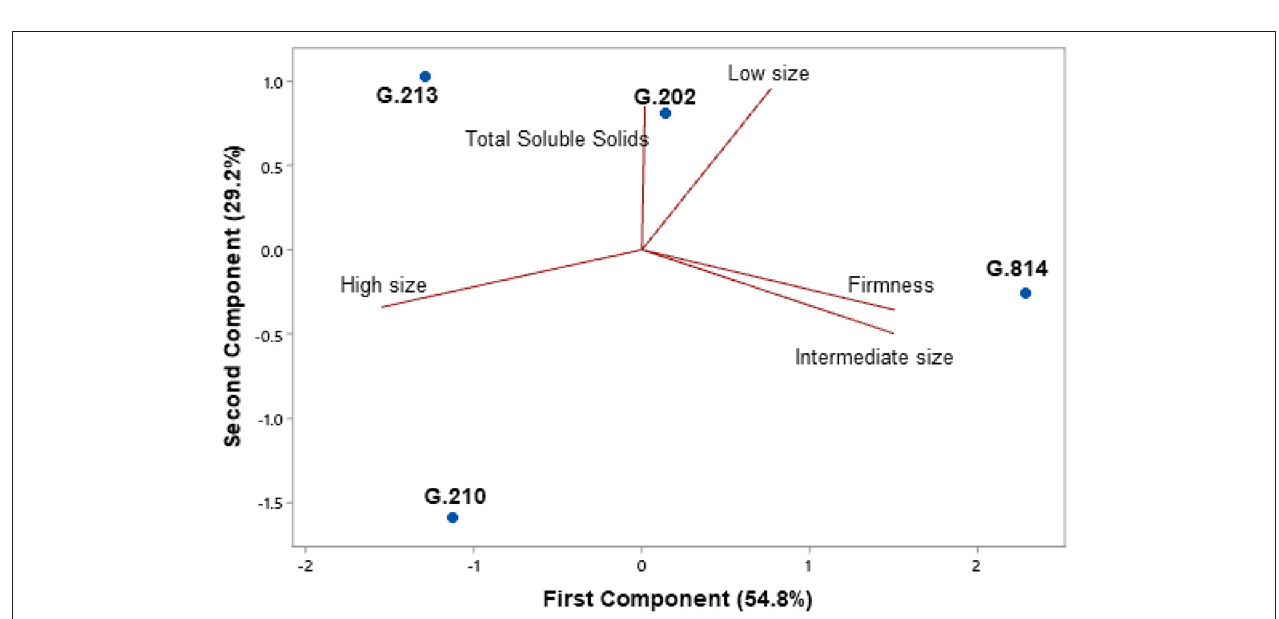
FIGURE 12 | Fruit quality analysis of the Fuji Suprema cultivar on the Geneva ® series rootstocks. Vacaria -